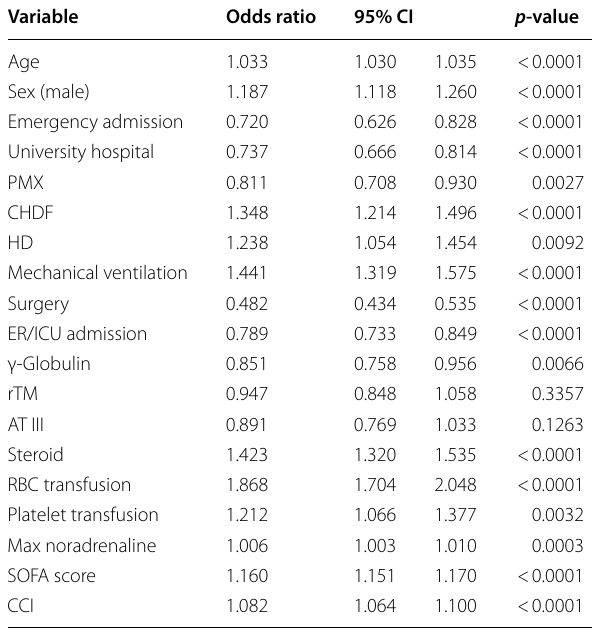
Table 1 28-day mortality odds ratio in the multivariate logistic regression